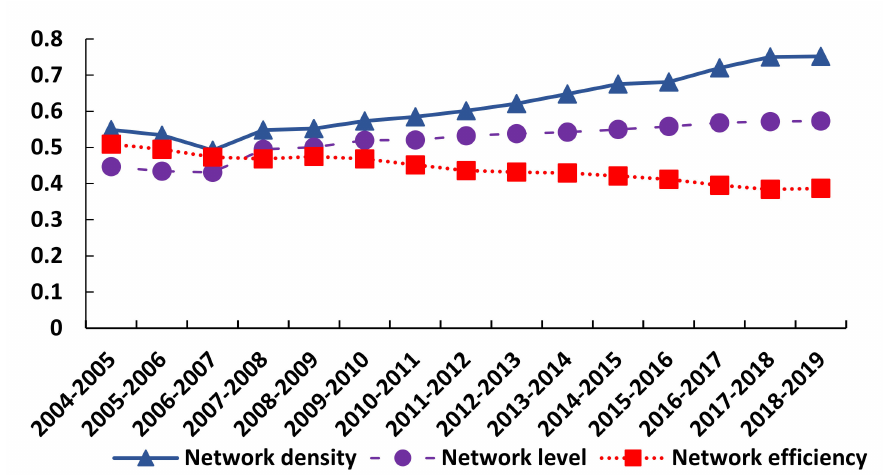
Figure 7. Time series changes in the structure of the spatial correlation network of health resource agglomeration capacities in